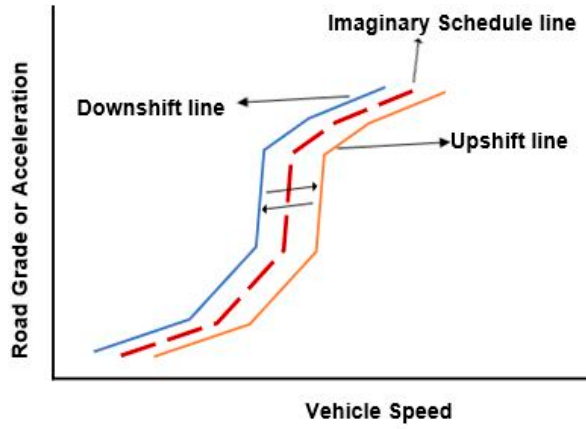
Figure 4. Imaginary schedule line or separation line for the gearshift.